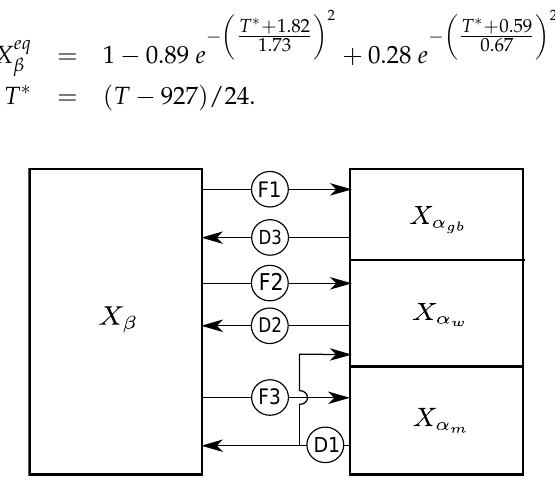
Figure 1. Phase-change mechanism.